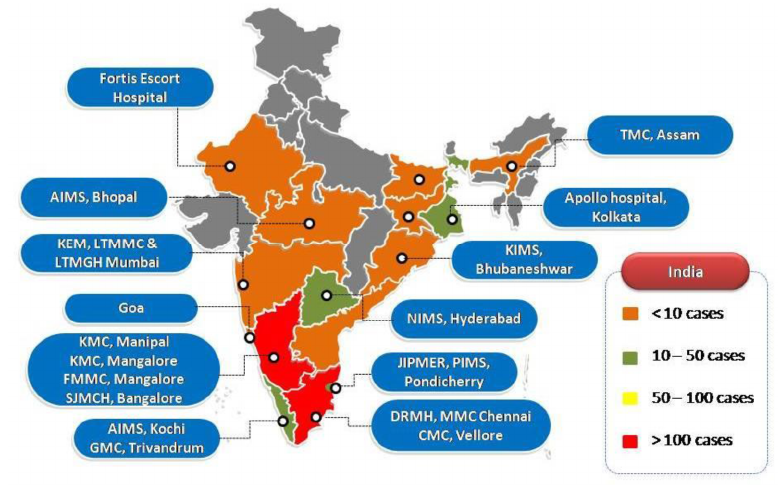
Figure 1. Cases reported from different parts of India and centers equipped to diagnose cases of melioidosis.